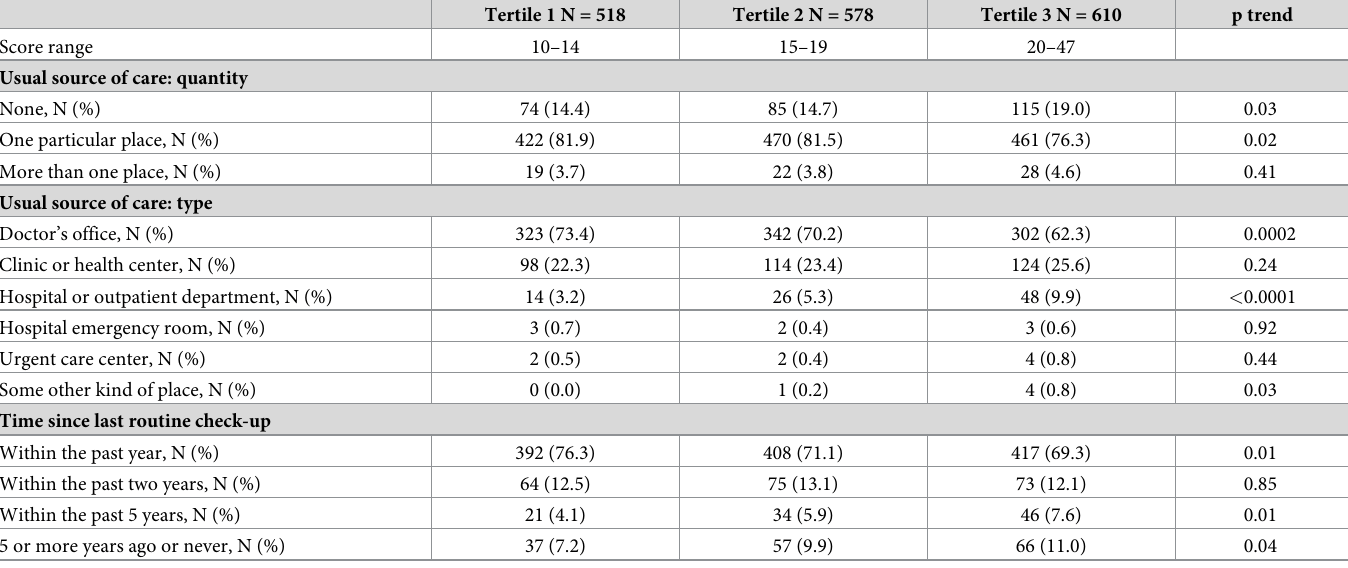
Table 2. Report of usual source of care (quantity and type) and routine healthcare utilization across tertiles of total neighborhood perception score for participants in the Dallas Heart Study (N = 1706) (2007–2009).